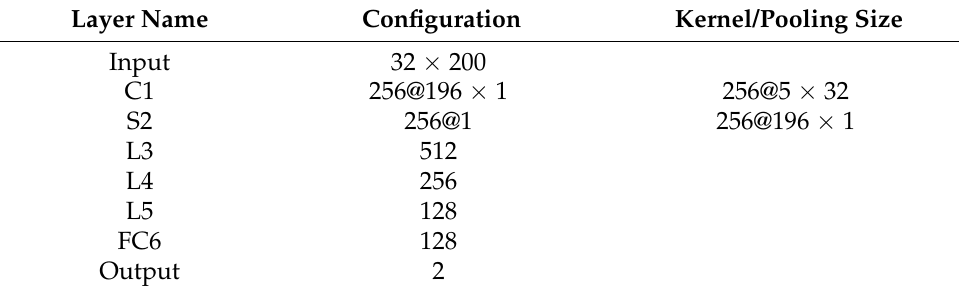
Table 3. The detailed structure of improved CNN